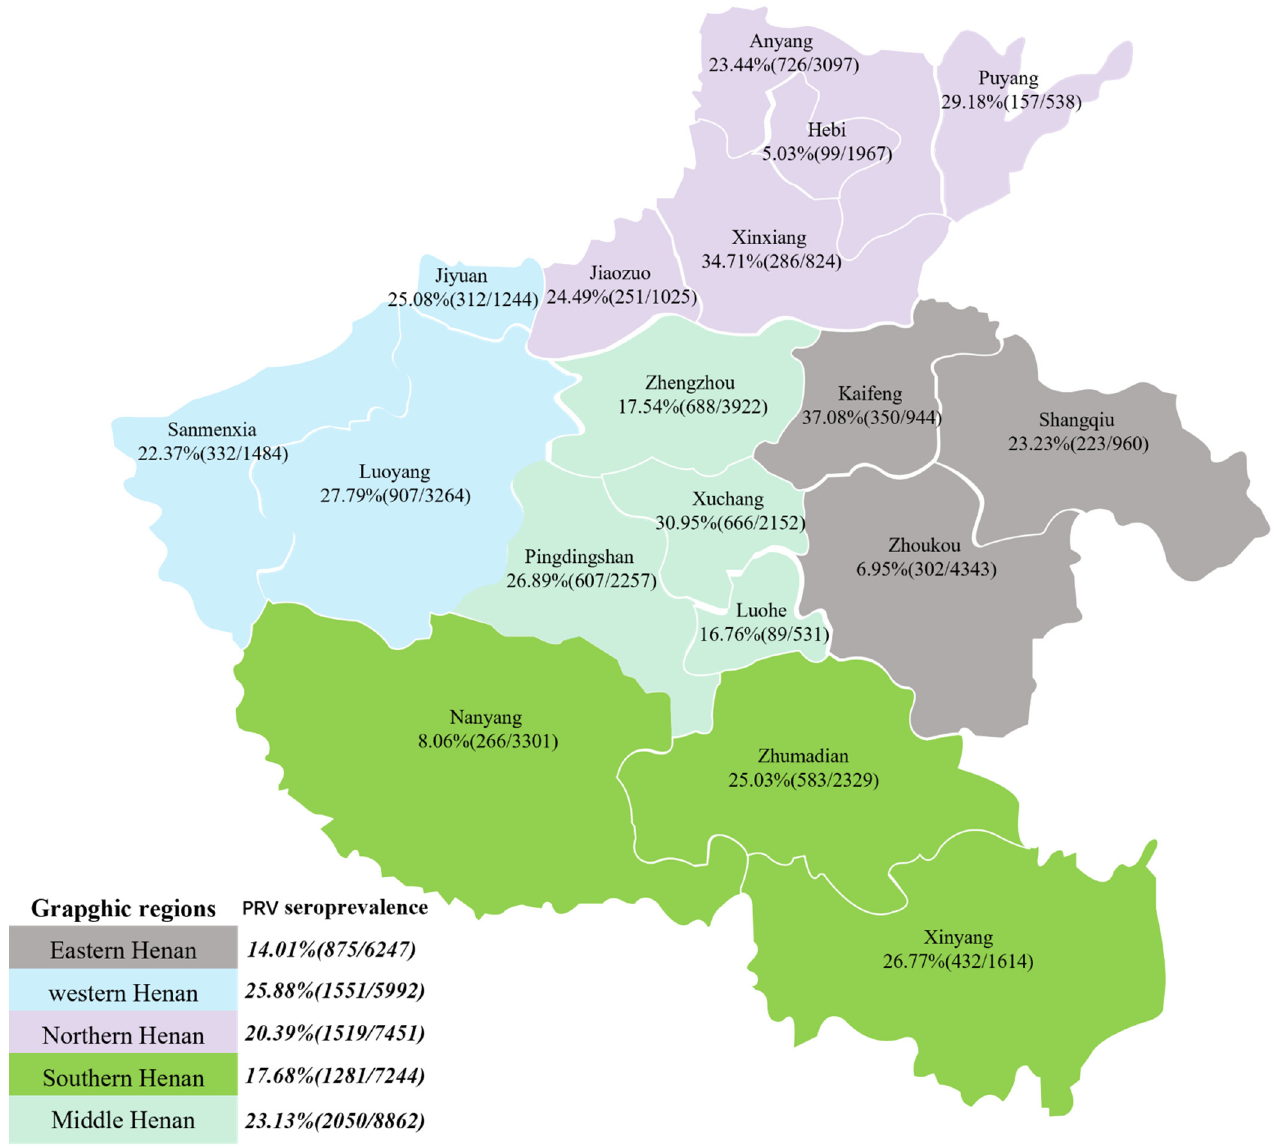
Figure 1. Seroprevalence of pseudorabies virus (PRV) in different geographical regions in the Henan province of China during 2019–2021. province of China during